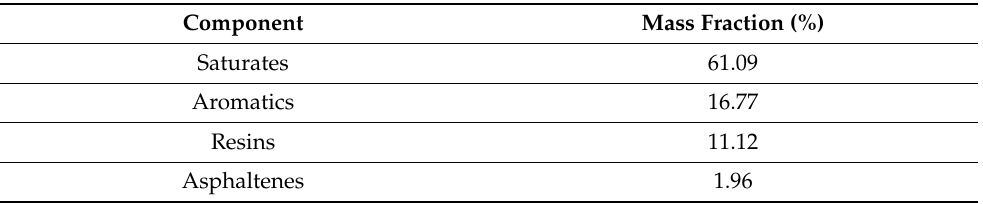
Table 1. SARA analysis of crude oil.